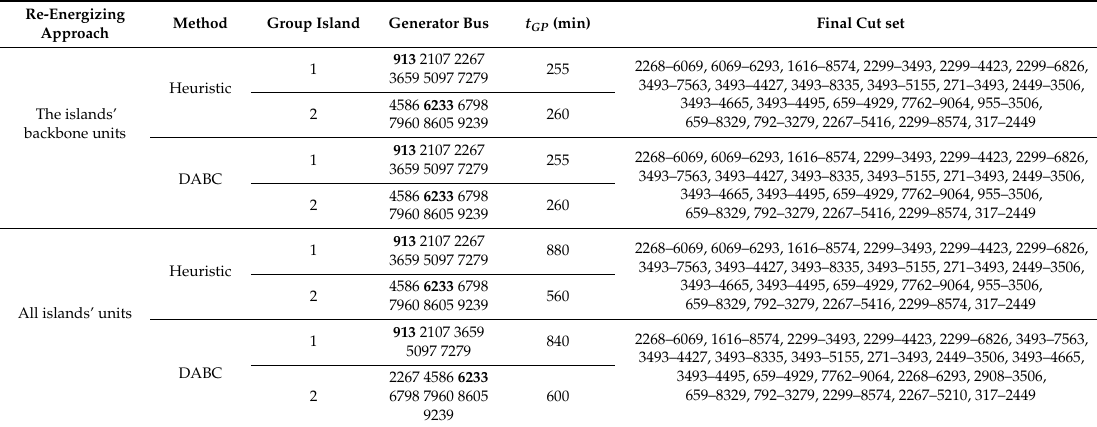
Table 7. 89 bus European test system